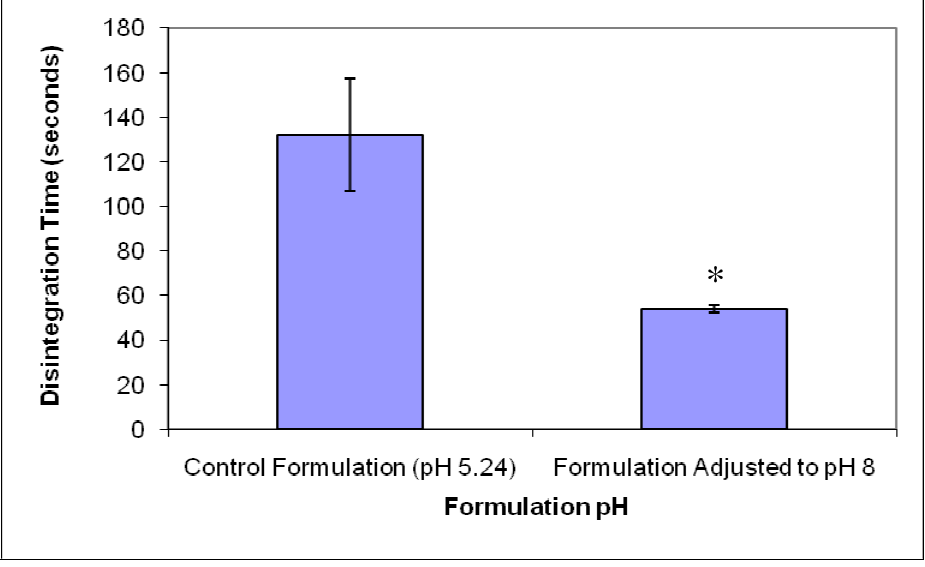
Figure 4. The effect of formulation pH on the disintegration time of the freeze-dried tablets (mean ± S.E., n = 3) (* statistically